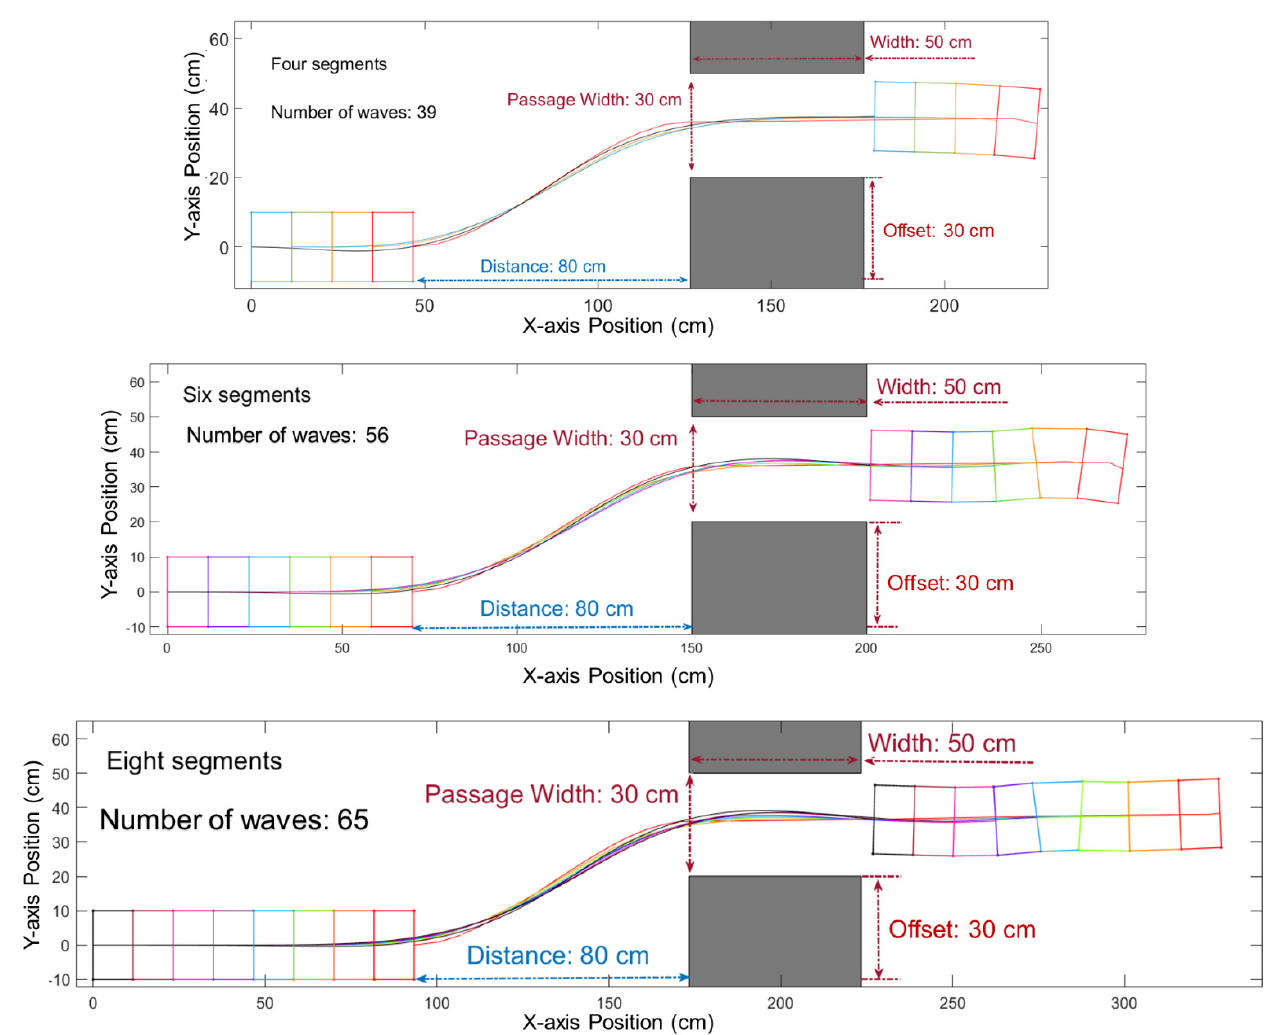
Figure 11. Robots with four, six, and eight segments passing through the same obstacles. The number of waves increases with the increasing number of segments in order for the entire body of the robot to move through the obstacle.